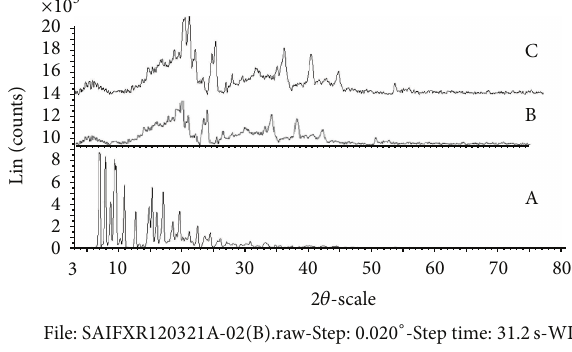
Figure 10: A-Cyclosporine, B-blank nanoparticles, and C-drug loaded